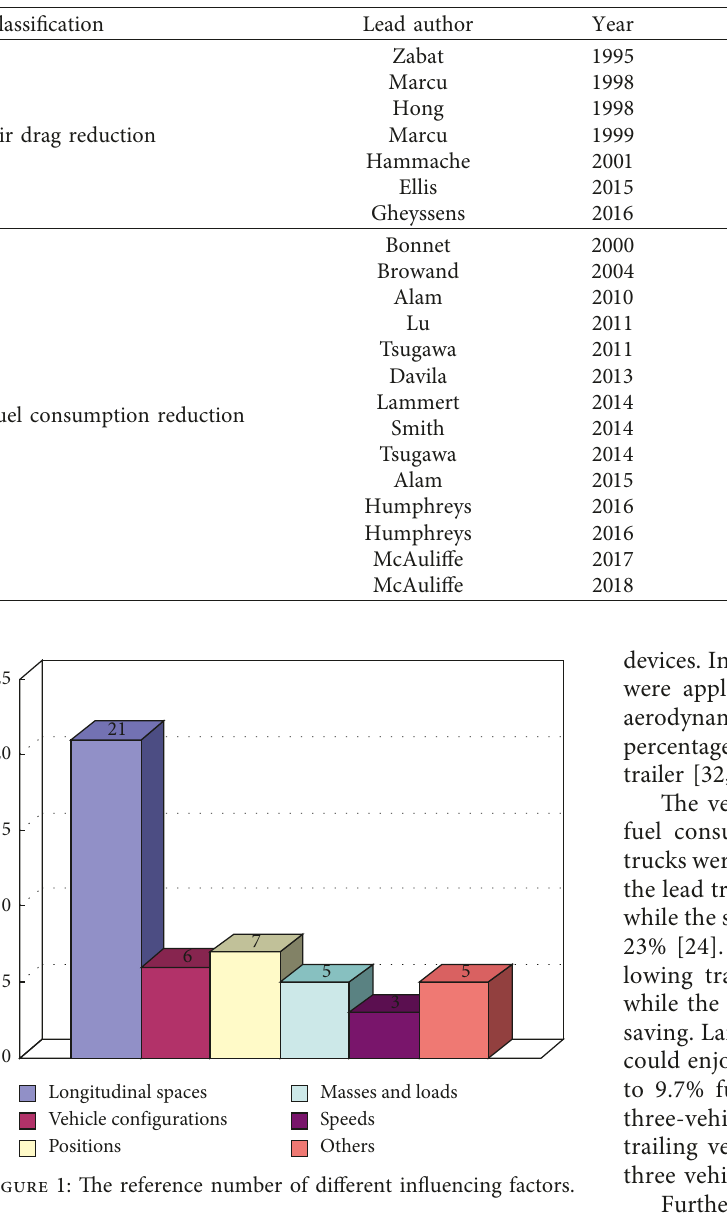
Table. 1: Summary of primary